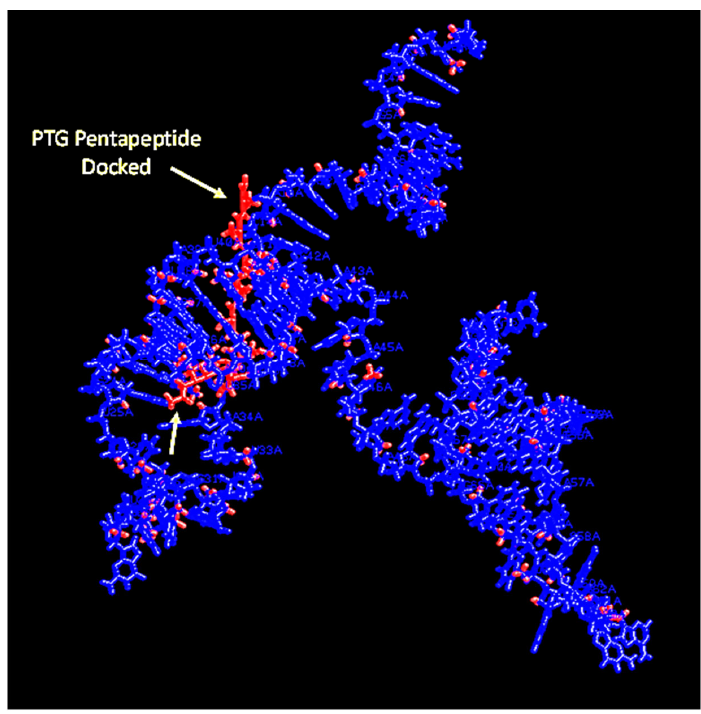
Figure 8. The NAG ‐ 13F aptamer bound to a short segment of peptidoglycan (PTG) pentapeptide Figure 8. The NAG-13F aptamer bound to a short segment of peptidoglycan (PTG) pentapeptide shown in RasMol. shown in